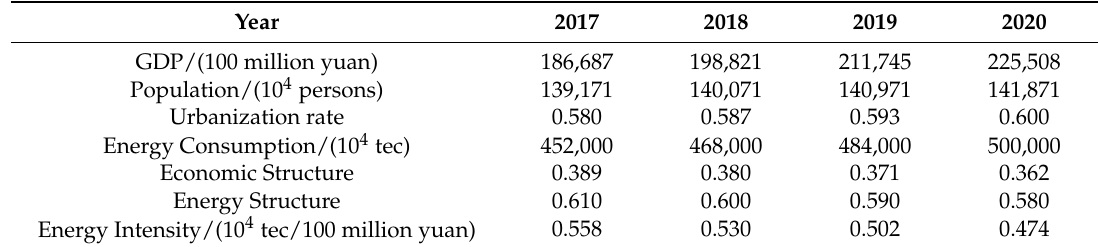
Table 4. The forecasting values of all factors from 2017 to 2020 in China.